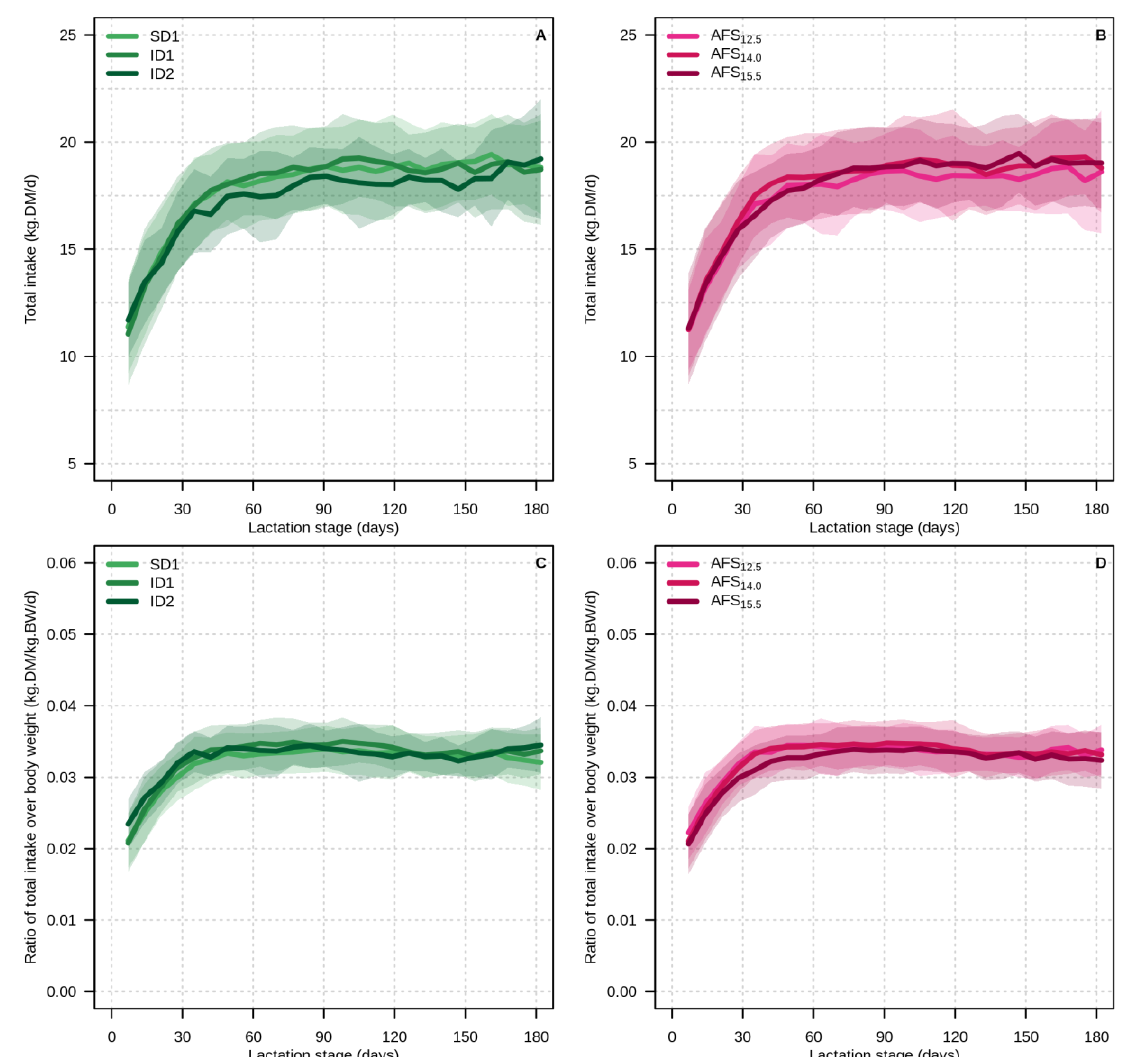
Figure 3. (A and B) daily dry matter intake and (C and D) daily ratio of dry matter intake over body weight of primiparous cows during lactation by (A and C) feeding treatment (SD, ID1, ID2: animals fed a standard (SD) or increased-plane (ID1 & ID2) feeding treatment) and (B and D) class of age at first service (AFS). Shaded areas are the dispersions of the data around the means (± one standard deviation). AFS influenced BW at calving, and was lower for AFS 12.5 than for AFS 14.0 and AFS 15.5 cows (509 vs 539 and 549 kg, respectively, P < 0.001; Table 6; Fig. 2B). BCS at calving was higher for AFS 15.5 than for AFS 12.5 and AFS 14.0 cows (2.45 vs 2.35 and 2.35, respectively; P < 0.05). After calving, BCS did not differ between AFS classes. On a 308 d basis, no difference in milk yield, composition or FPCM was observed. Only peak milk yield tended to be lower for AFS 12.5 cows (30.2 kg) than for AFS 14.0 and AFS 15.5 cows (31.6 and 31.7 kg, respectively; Fig. 2D; Table